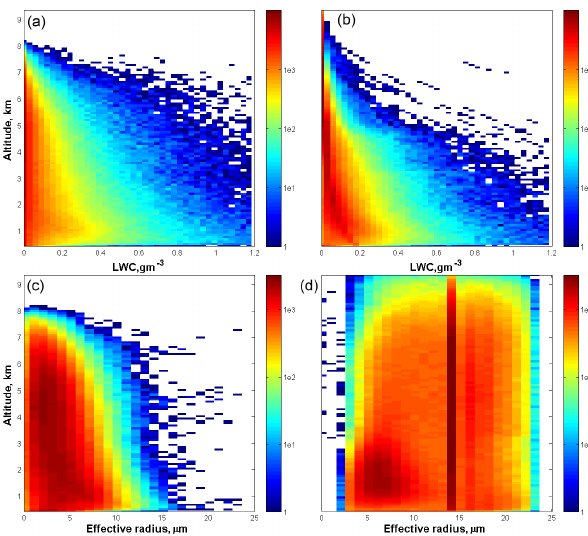
Fig. 4. CFADs of MICROBASE and UU LWC and r e at the SGP site from 1998 to 2006.